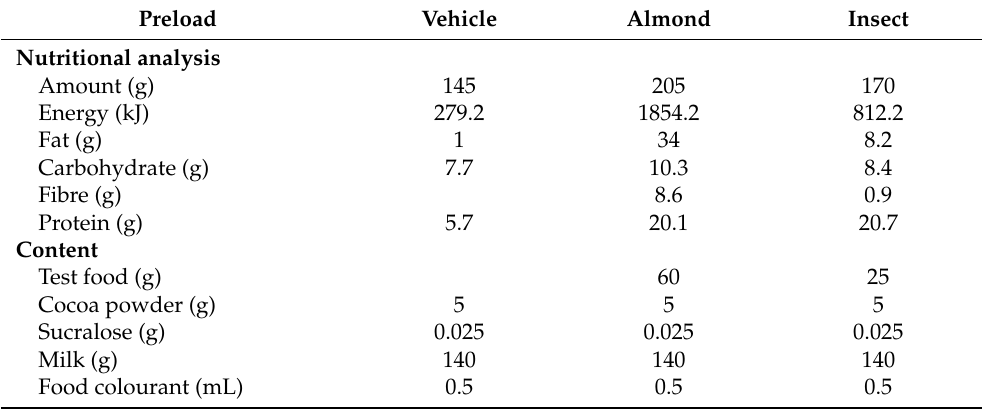
Table 1. Nutritional composition and content of the three preloads. Preload Vehicle Almond